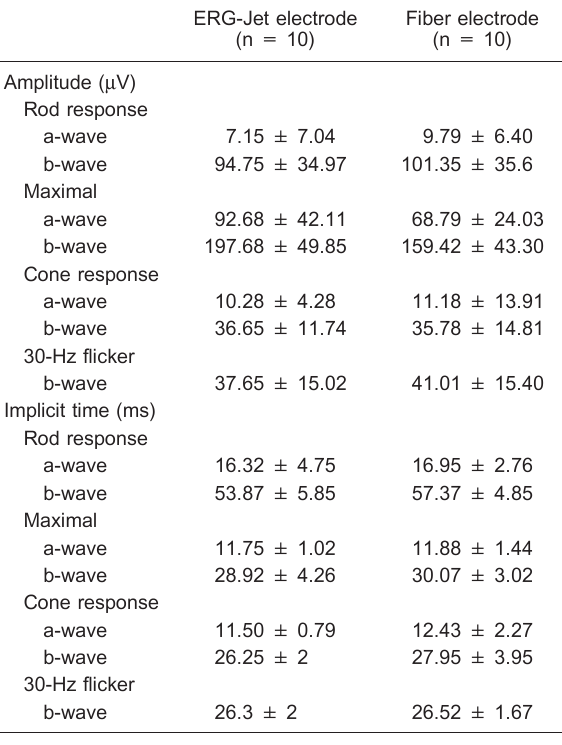
Table 1. Comparison of the amplitudes and implicit time obtained following a standardized electroretinogram (ERG) with the ERG-Jet lens electrode and with the fiber electrode prototype.